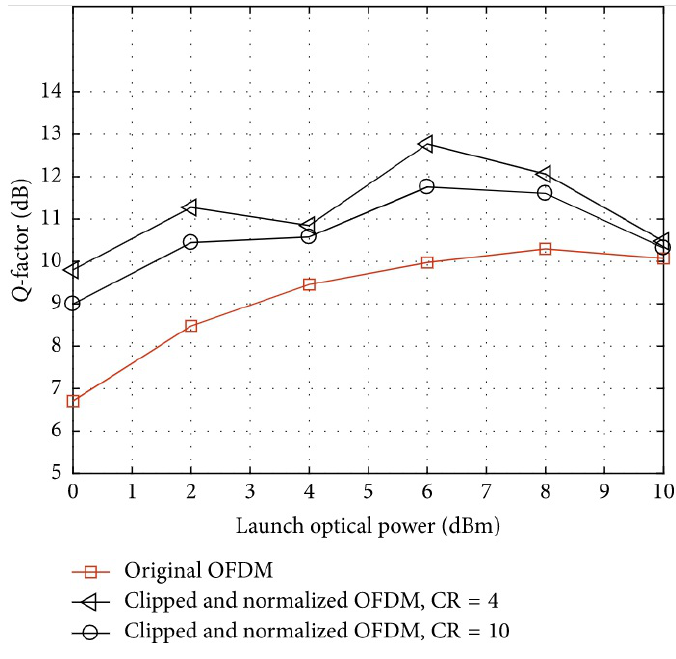
Fig. 6 OFDM optical domain signal power comparison diagram.